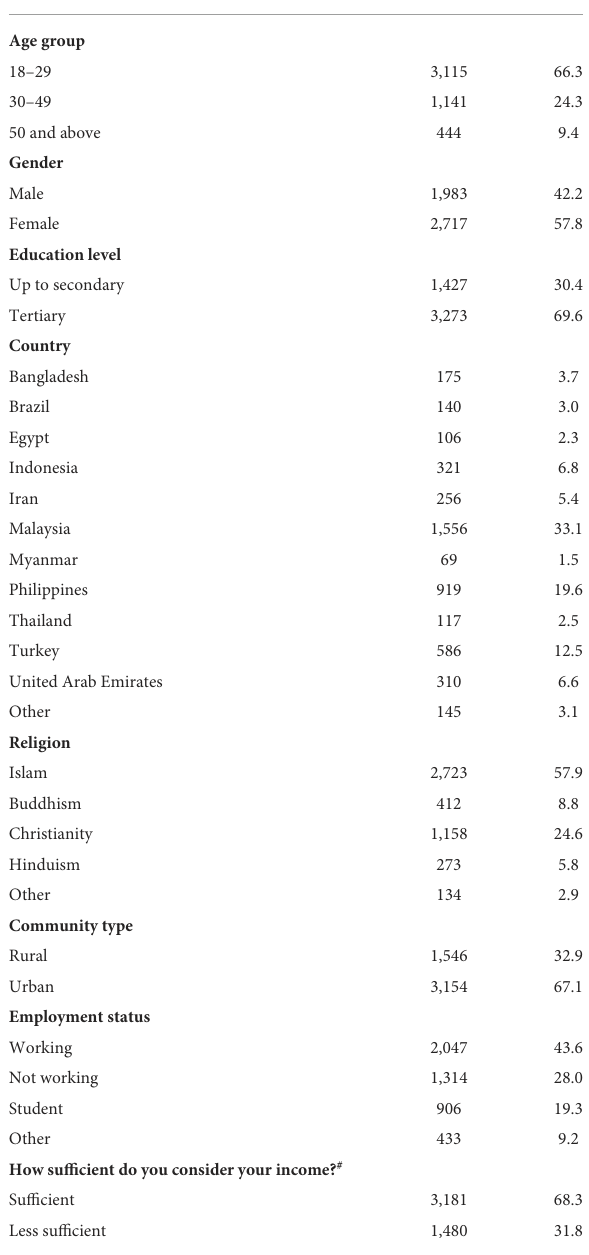
TABLE 1 Socio-demographic characteristics of